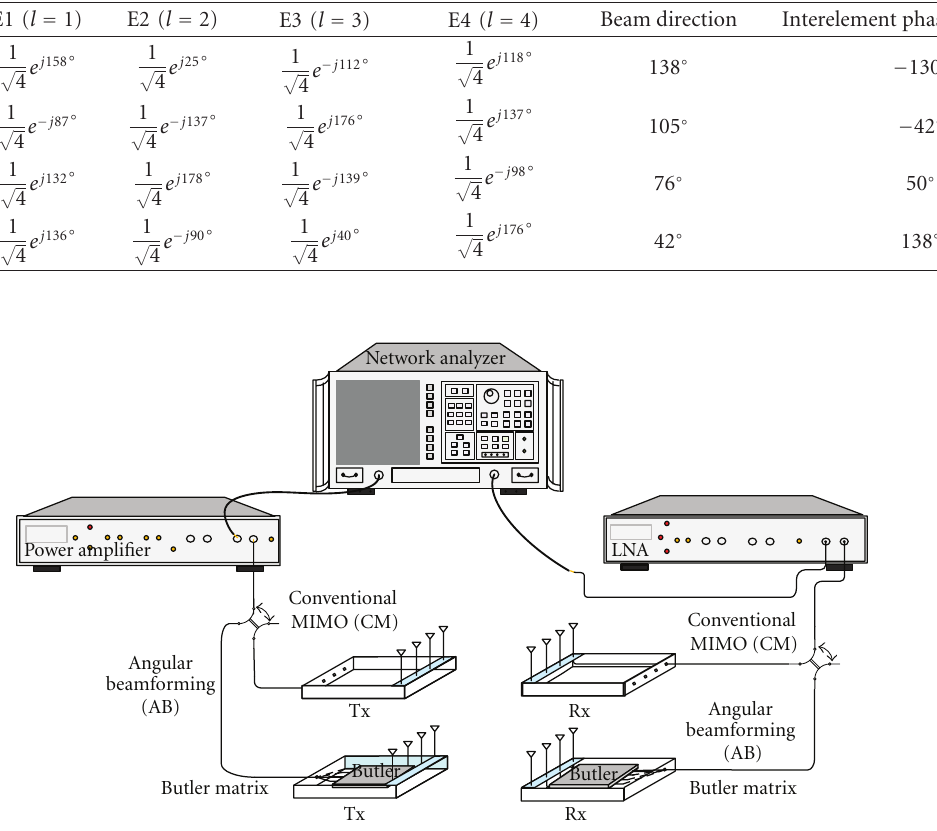
Figure 6: Block diagram of measurement